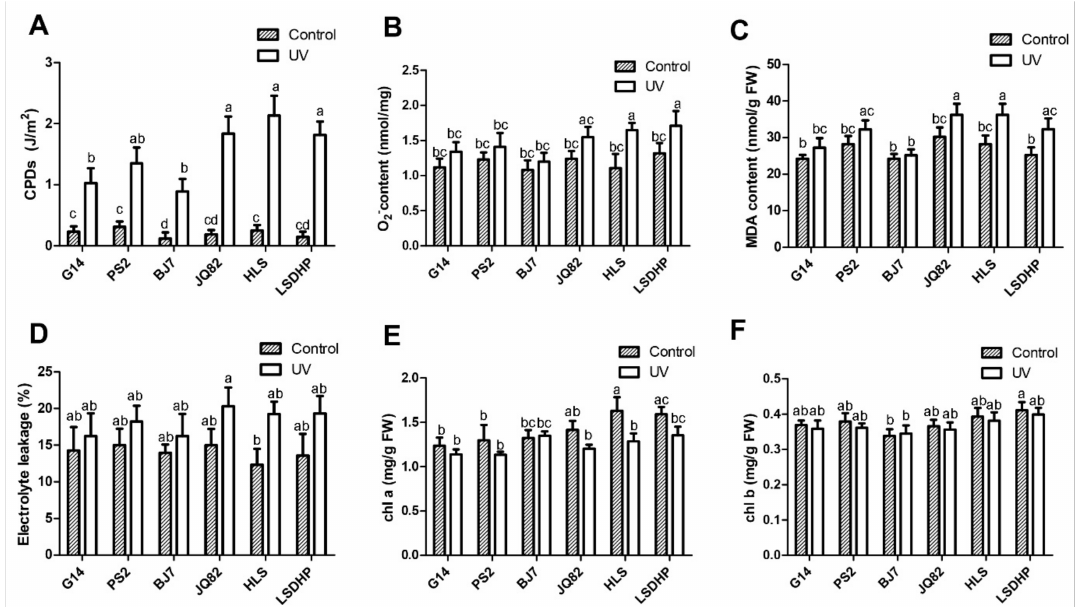
Figure 6. UV-B tolerance analyses of the six mulberry cultivars. Analysis of DNA damage, superoxide accumulation, lipid peroxidation, membrane injury, and chlorophyll content in leaves of mulberry cultivars BJ7, G14, PS2, HLS, JQ82, and LSDHP after the UV-B treatment. ( A ) CPDs levels. ( B ) O 2 − content. ( C ) MDA content. ( D ) Electrolyte leakage. ( E , F ) chlorophyll content (Chl a and Chl b).